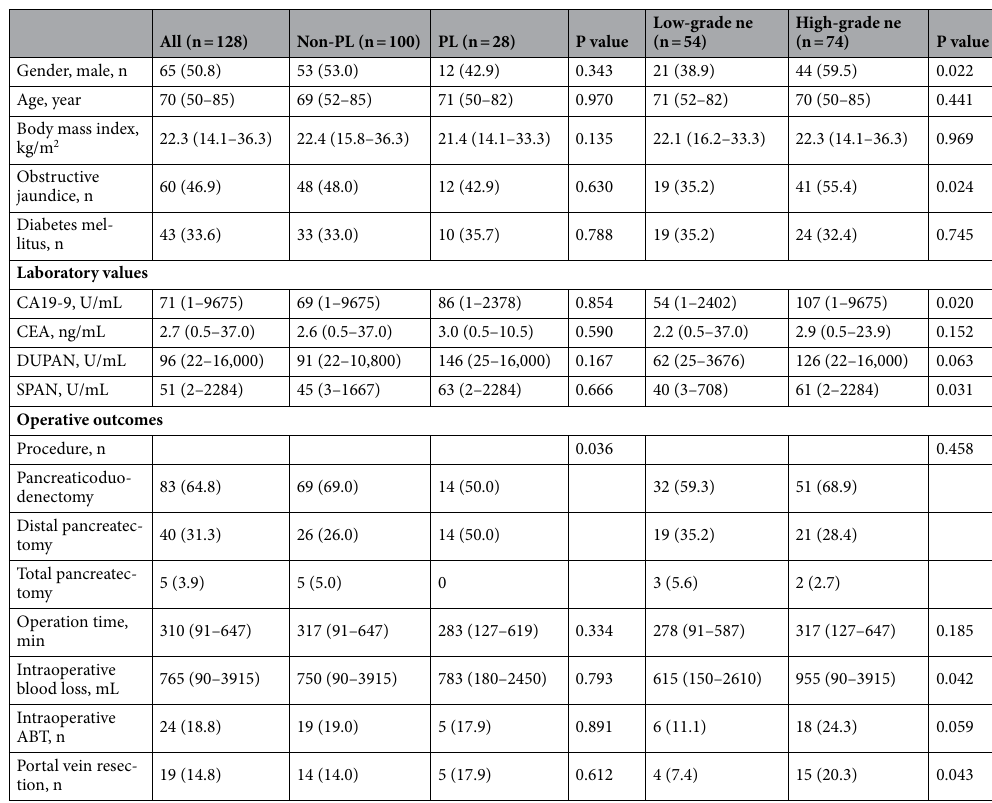
Table 1. Comparison of preoperative, operation-related characteristics. ABT allogeneic red blood cell transfusion, CA19-9 carbohydrate antigen 19-9, CEA carcinoembryonic antigen, DUPAN duke pancreatic monoclonal antigen, ne nerve invasion, PL extrapancreatic nerve plexus invasion, SPAN s-pancreas